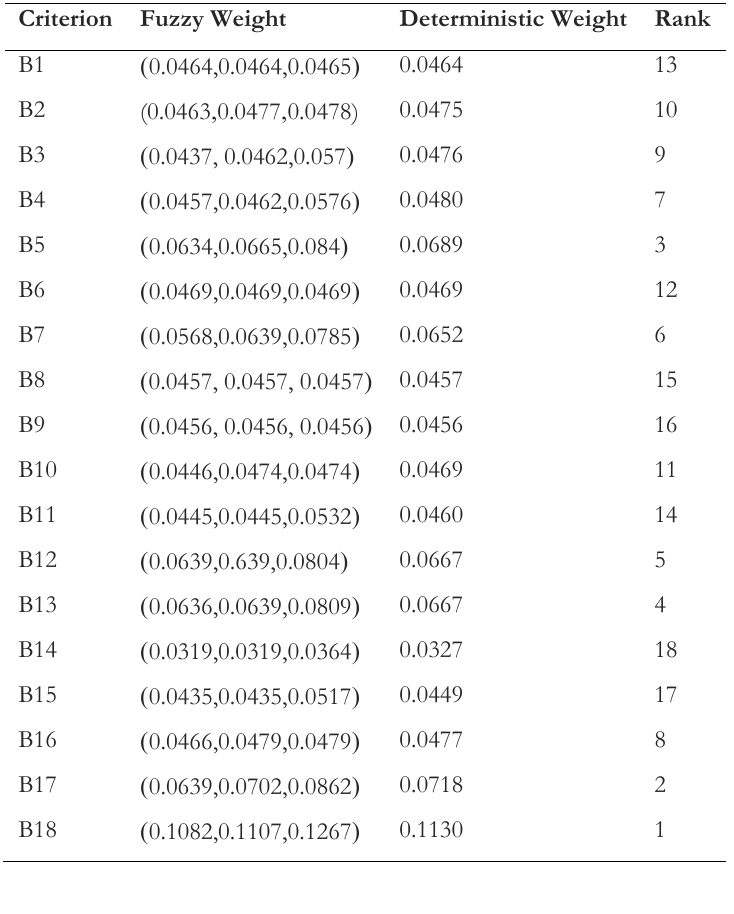
Table 8. Weights and the final ranking of executive challenges.